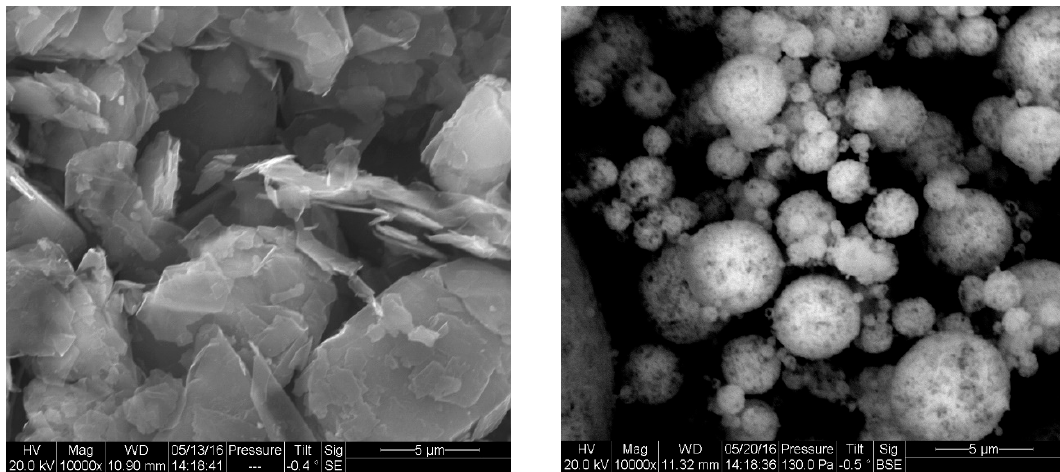
Figure A1. SEM images of: graphite particles ( left ); and LTO particles ( right ).